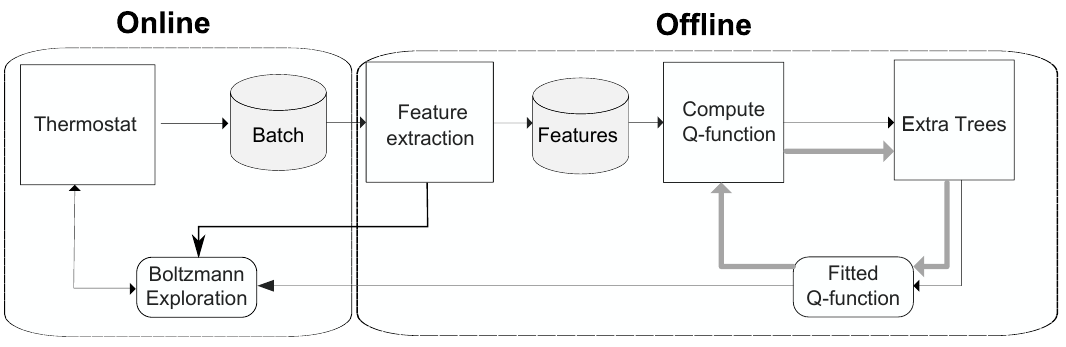
Figure 3. Online and o ffl ine loop of our proposed approach, which consists of a feature extraction (o ffl ine), fitted Q-iteration (o ffl ine) and Boltzmann exploration